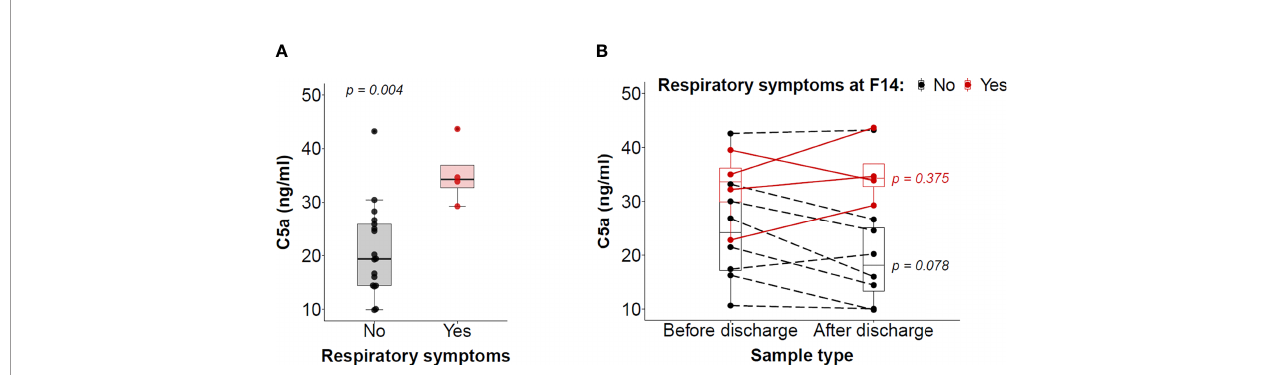
FIGURE 3 | Association between serum C5a levels and the presence of respiratory symptoms. (A) Association between serum C5a levels and the presence or not of respiratory symptoms two weeks after hospital discharge. (B) Evolution of serum C5a levels from the last sample at hospitalization and the follow-up sample at F14 in patients who suffered respiratory problems during their hospitalization. Patients are divided into patients with or without respiratory problems in the follow-up visit (red and black, respectively). Differences were analyzed with the Wilcoxon signed-rank test for paired